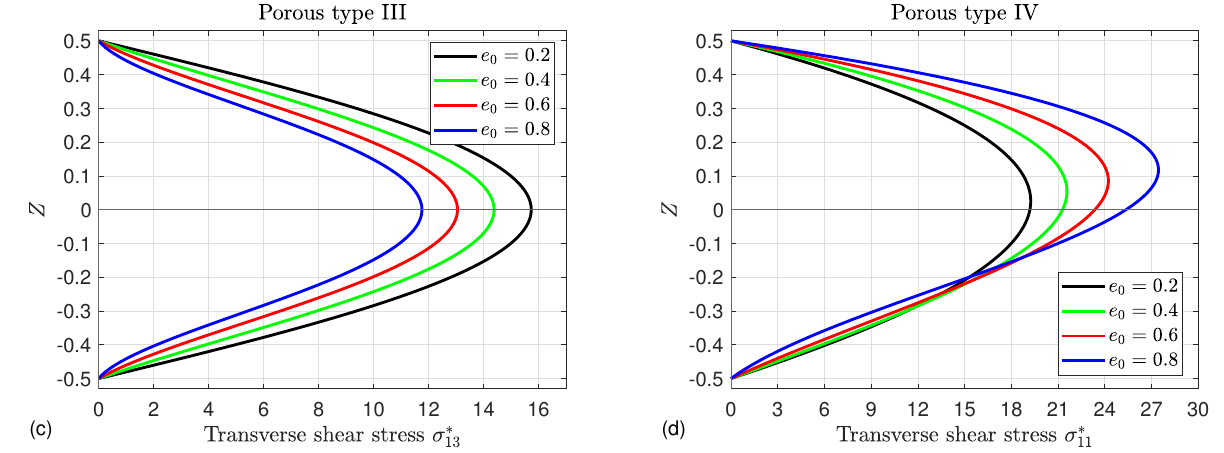
in FG porous nanocom- 13